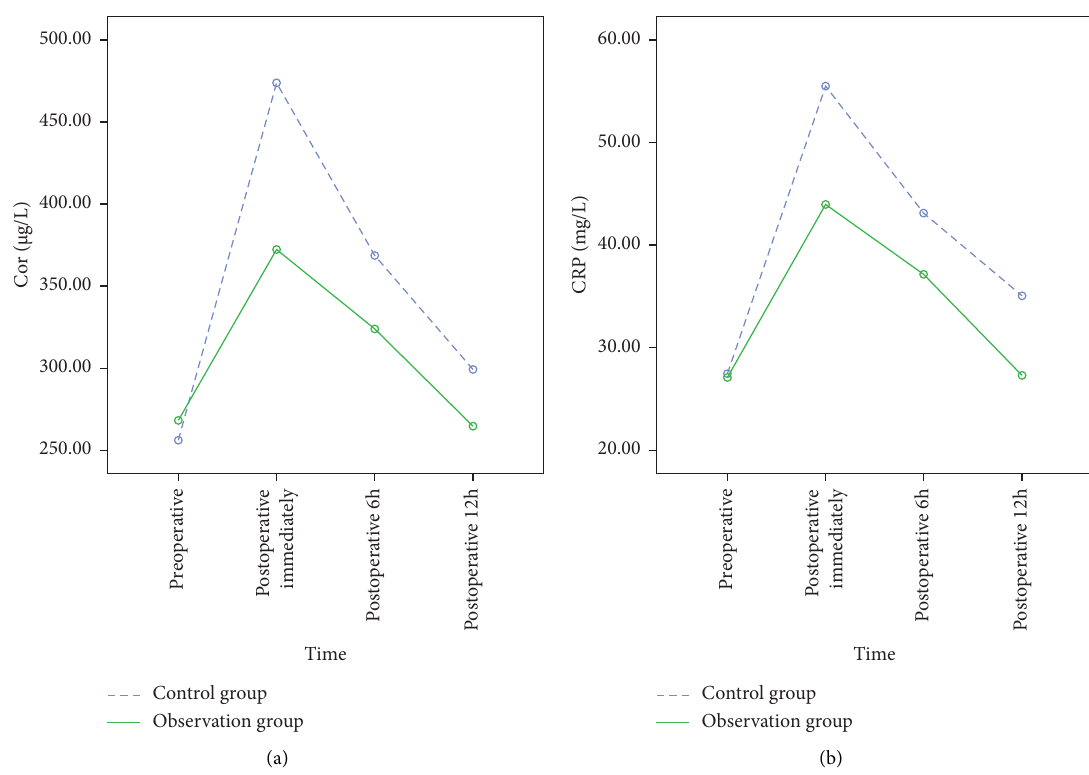
Figure 3: Comparison of perioperative serum stress response indexes between the two groups (Note. (a) Comparison of perioperative Cor levels between observation group and control group; (b) comparison of perioperative CRP levels between observation group and control group). Table 3: Comparison of perioperative serum stress response indexes between the two groups ( x ± s ).